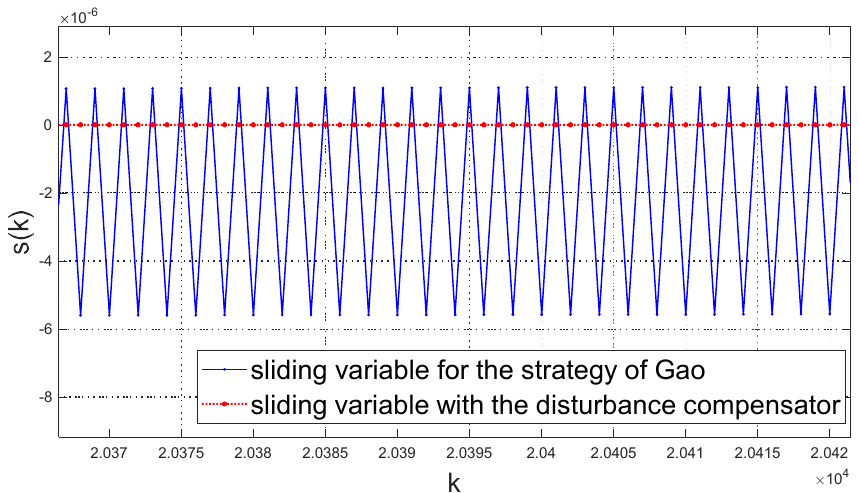
Figure 2. Comparison of the discrete-time sliding variables.